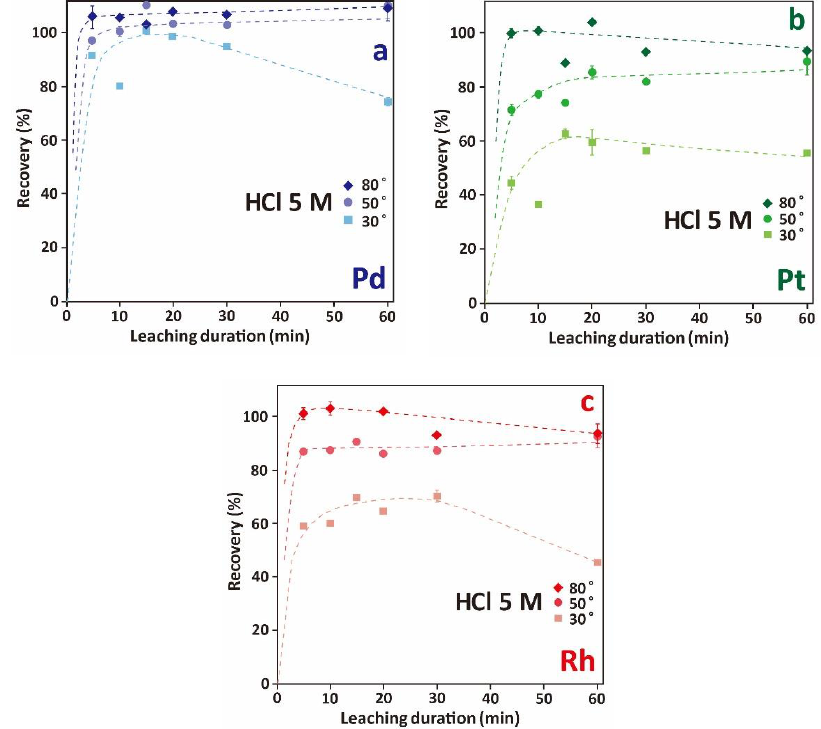
Figure 10. The effect of leaching duration and temperature on PGE recovery ( a ) Pd, ( b ) Pt, and ( c ) Rh at a constant hydrochloric acid concentration. a constant hydrochloric acid